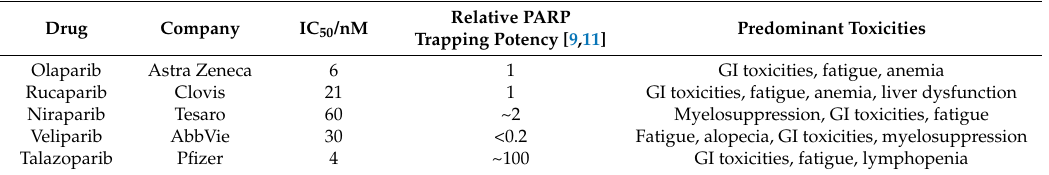
Table 1. Current PARP inhibitors approved or in late stage